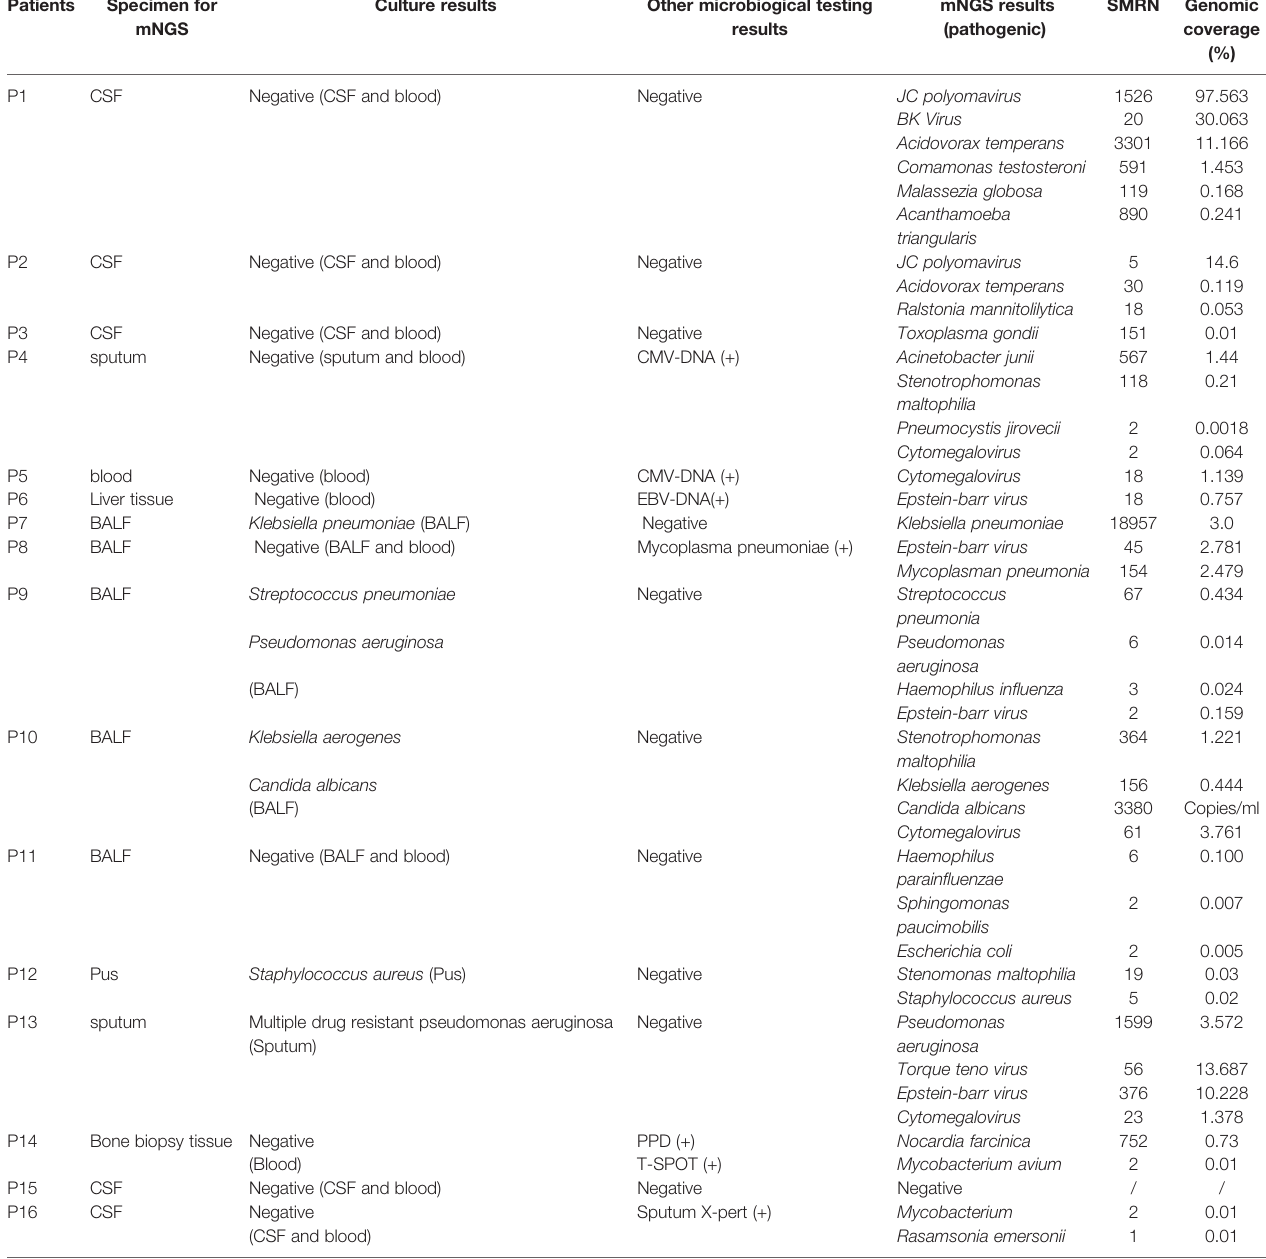
TABLE 1 | Results of CMT and mNGS of various samples for patients with PID. Patients